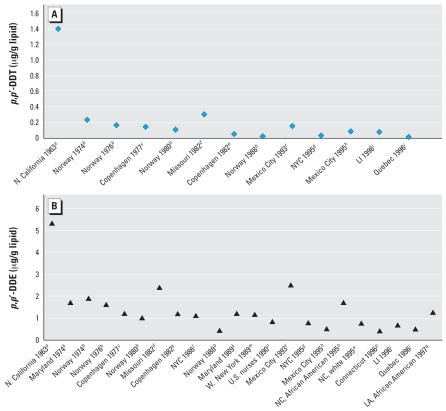
Reported p,p′-DDT (A) and p,p′-DDE (B) levels in blood observed in epidemiologic studies of breast cancer by year and place of blood draw (note the difference in scales). Abbreviations: LA, Los Angeles, CA; LI, Long Island, NY; N, northern; NC, North Carolina; NYC, New York City; W, western. Values shown are median, geometric mean, or arithmetic mean, depending on what was given in the original article. Only studies that reported lipid-adjusted levels in blood samples are included because lipids confound observed levels.aPresent study. bWard et al. (2000). cHoyer et al. (1998). dDorgan et al. (1999). eHoyer et al. (2000). fRomieu et al. (2000). gWolff et al. (2000a). hLopez-Carillo et al. (1997). iGammon et al. (2002). jDemers et al. (2000). kHelzlsouer et al. (1999). lWolff et al. (2000b). mMoysich et al. (1998). nHunter et al. (1997). oMillikan et al. (2000). pZheng et al. (2000). qGatto et al. (2007).